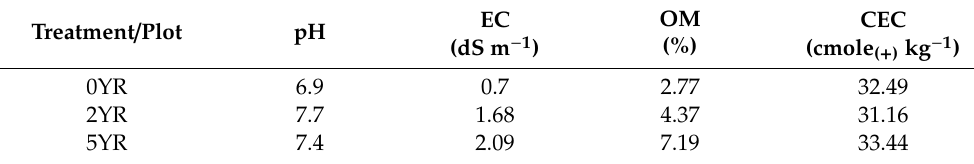
Table 1. Selected chemical properties for the soil of the three plots: pH, electrical conductivity (EC), organic matter (OM), and cation-exchange capacity